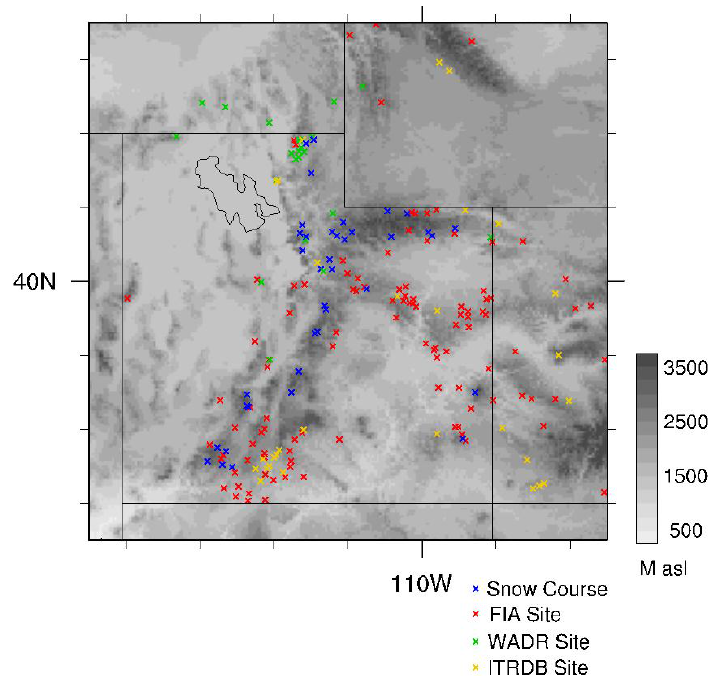
Figure 1. Terrain in the state of Utah (grayscale). Locations of snow course stations (blue x), and tree-ring data type, Forest Inventory and Analysis (FIA) plots (red x), Wasatch Dendroclimatology Research group (WADR) site (green x), and International Tree-Ring Data Bank (ITRDB) sites (yellow x). ITRDB and WADR sites are fully developed chronologies; FIA plots are locations of individual tree increment cores.